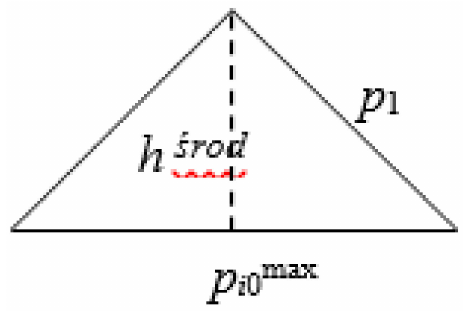
Figure 3. Determination of singular